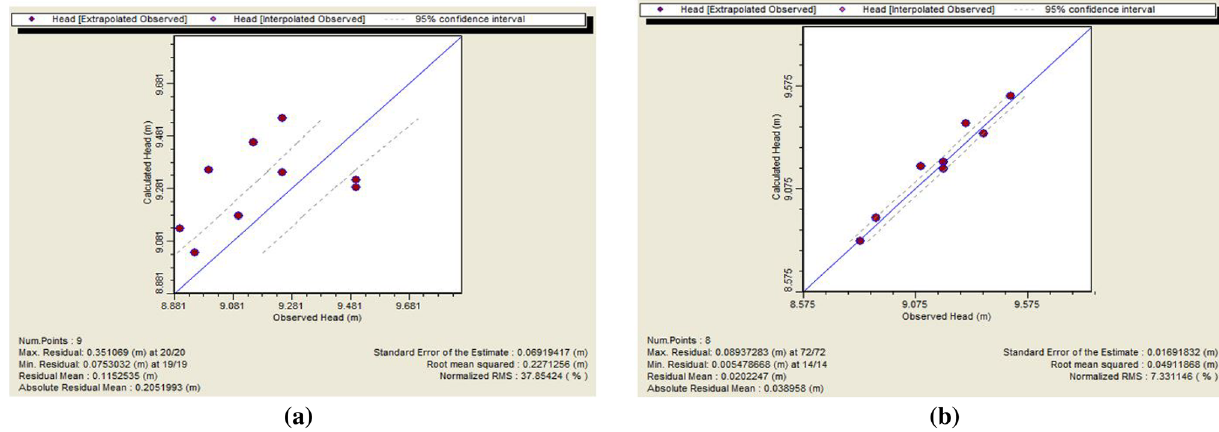
Fig. 7 Calculated head and the observed head for the unsteady-state condition a before calibration, b after